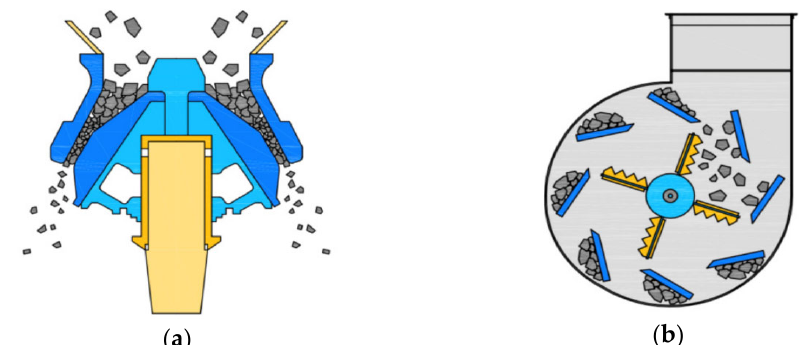
Figure 1. Mineral composition of cement.